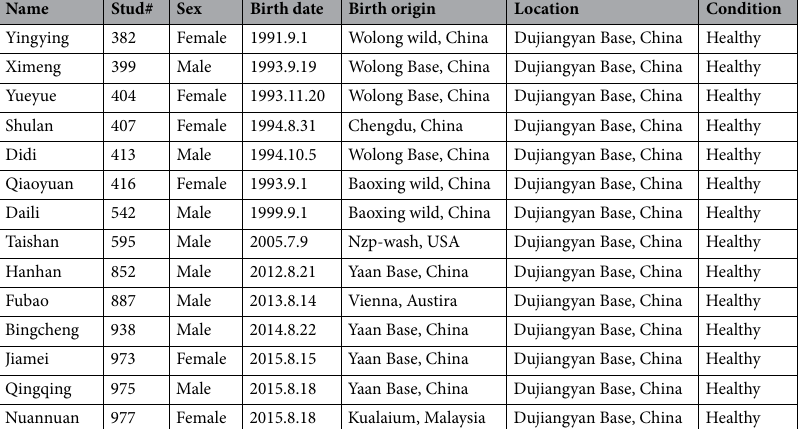
Table 1. Basic information about captive giant pandas in Dujiangyan